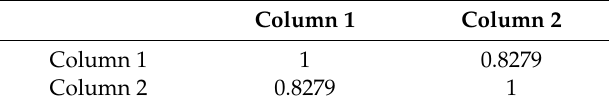
Table A6. Pearson correlation(see Table 1).